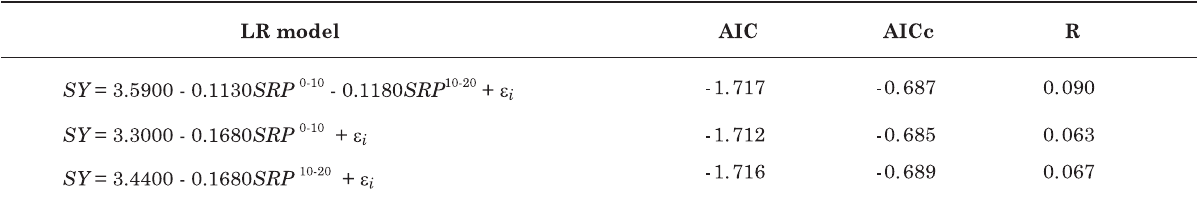
Table 3. Linear regression models (LR) to estimate soybean yield (SY) from soil penetration resistance measurements in both studied soil